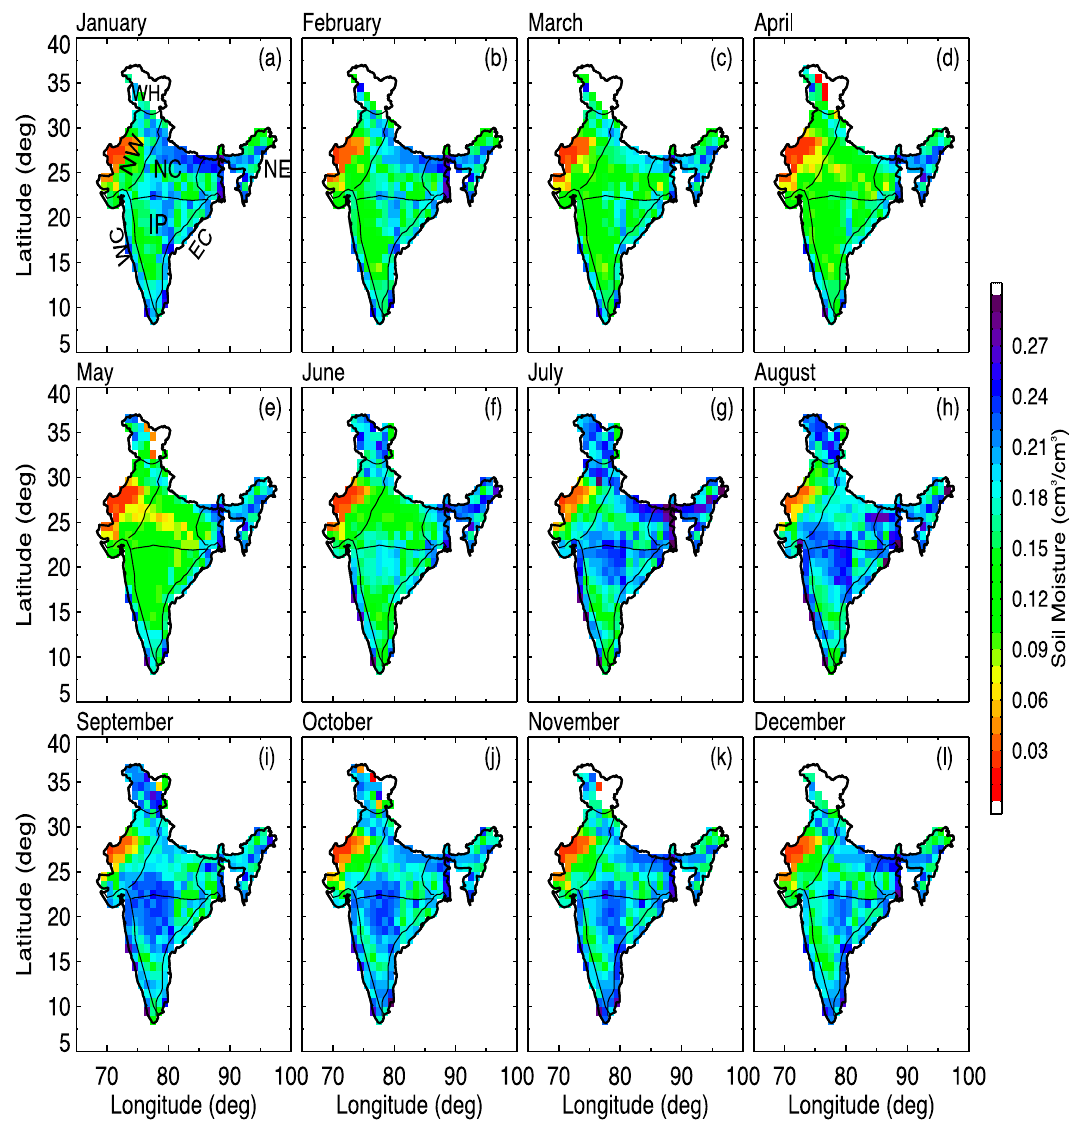
Figure 1. Spatial monthly climatology of soil moisture observed by AMSR over India for the period June 2002–April 2017. Seven different regions are indicated in the first panel: East coast (EC), Interior Peninsula (IP), North central (NC), North east (NE), North west (NW), West coast (WC), Western Himalayas (WH).